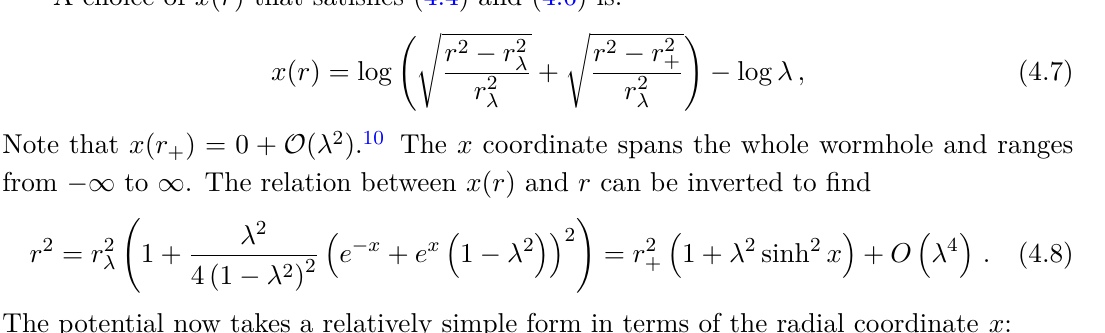
Figure 8. The potential V ( x ) plotted as a function of x with for µ = 1 , k = 1 , ω = 2 , r λ = 1 , and λ = { 10 − 1 , 10 − 2 , 10 − 3 } . As λ decreases, the width of the potential becomes larger and larger. The black hole potential is also depicted, shifted to line up with the λ = 10 − 3 graph for x > 0 . A choice of x ( r ) that satisfies (4.4) and (4.6)